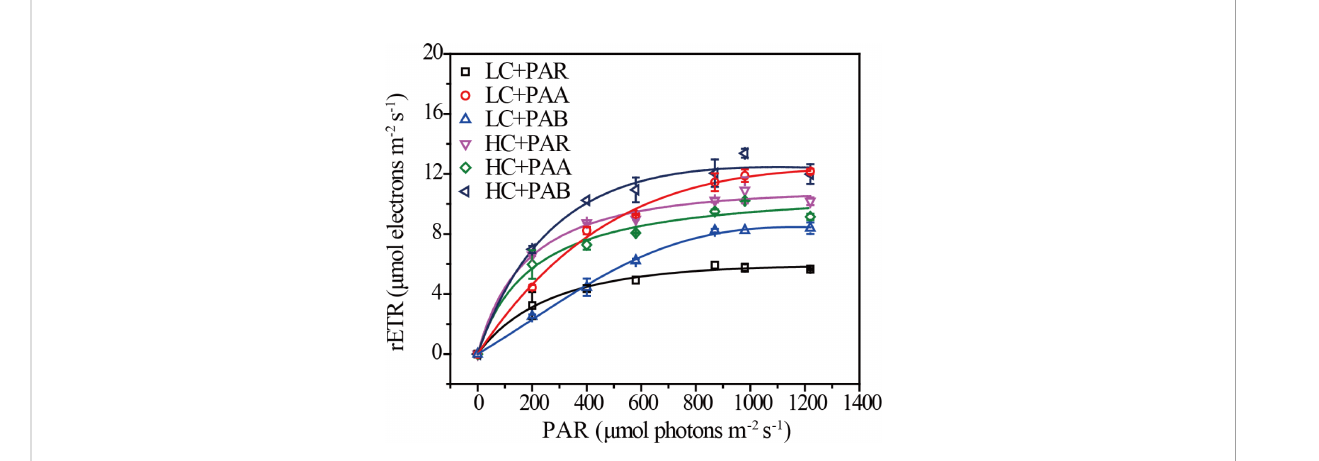
FIGURE 2 Rapid light curves (RLCs) of Rhodosorus sp. SCSIO-45730 under different p CO 2 levels and